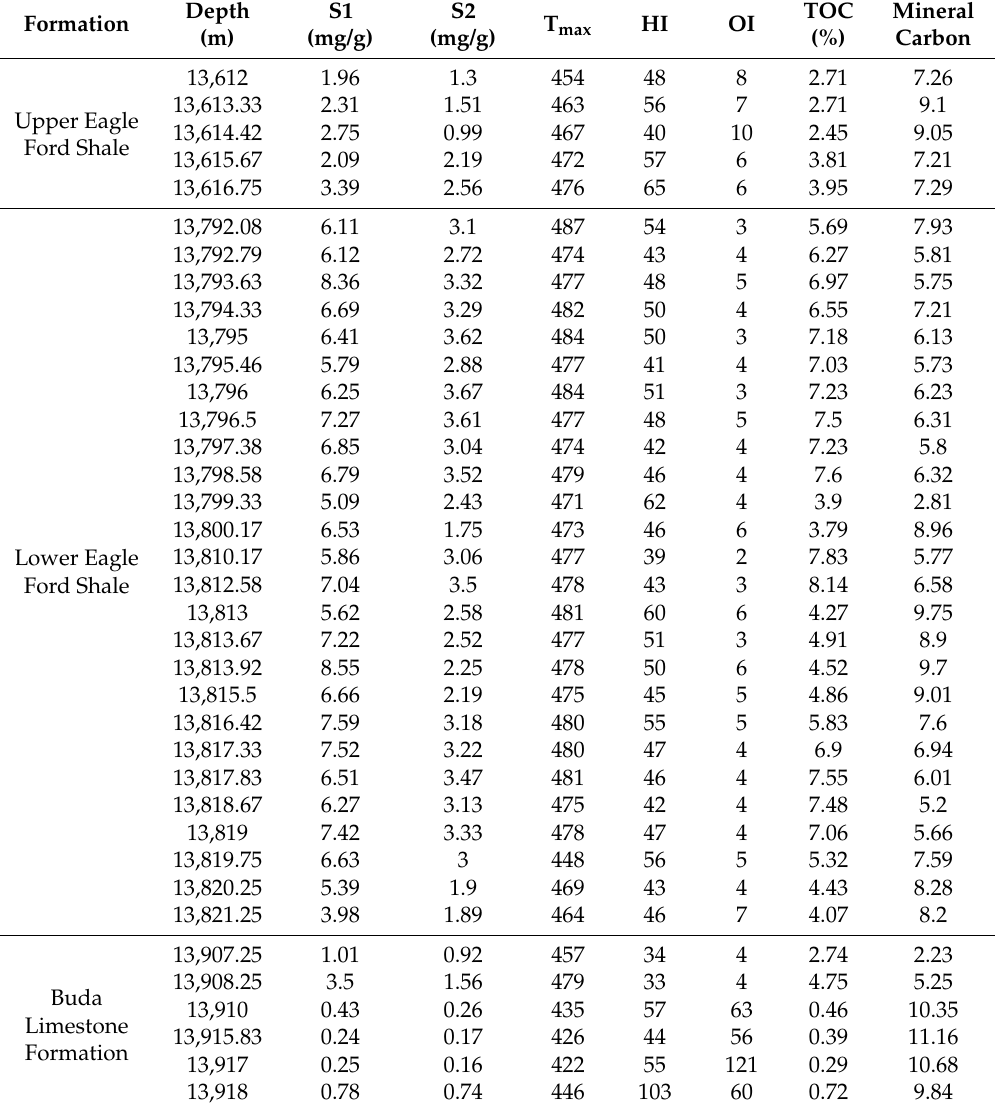
Table A1. Pyrolysis results of the Eagle Ford samples. HI—hydrogen index; OI—oxygen index; TOC—total organic